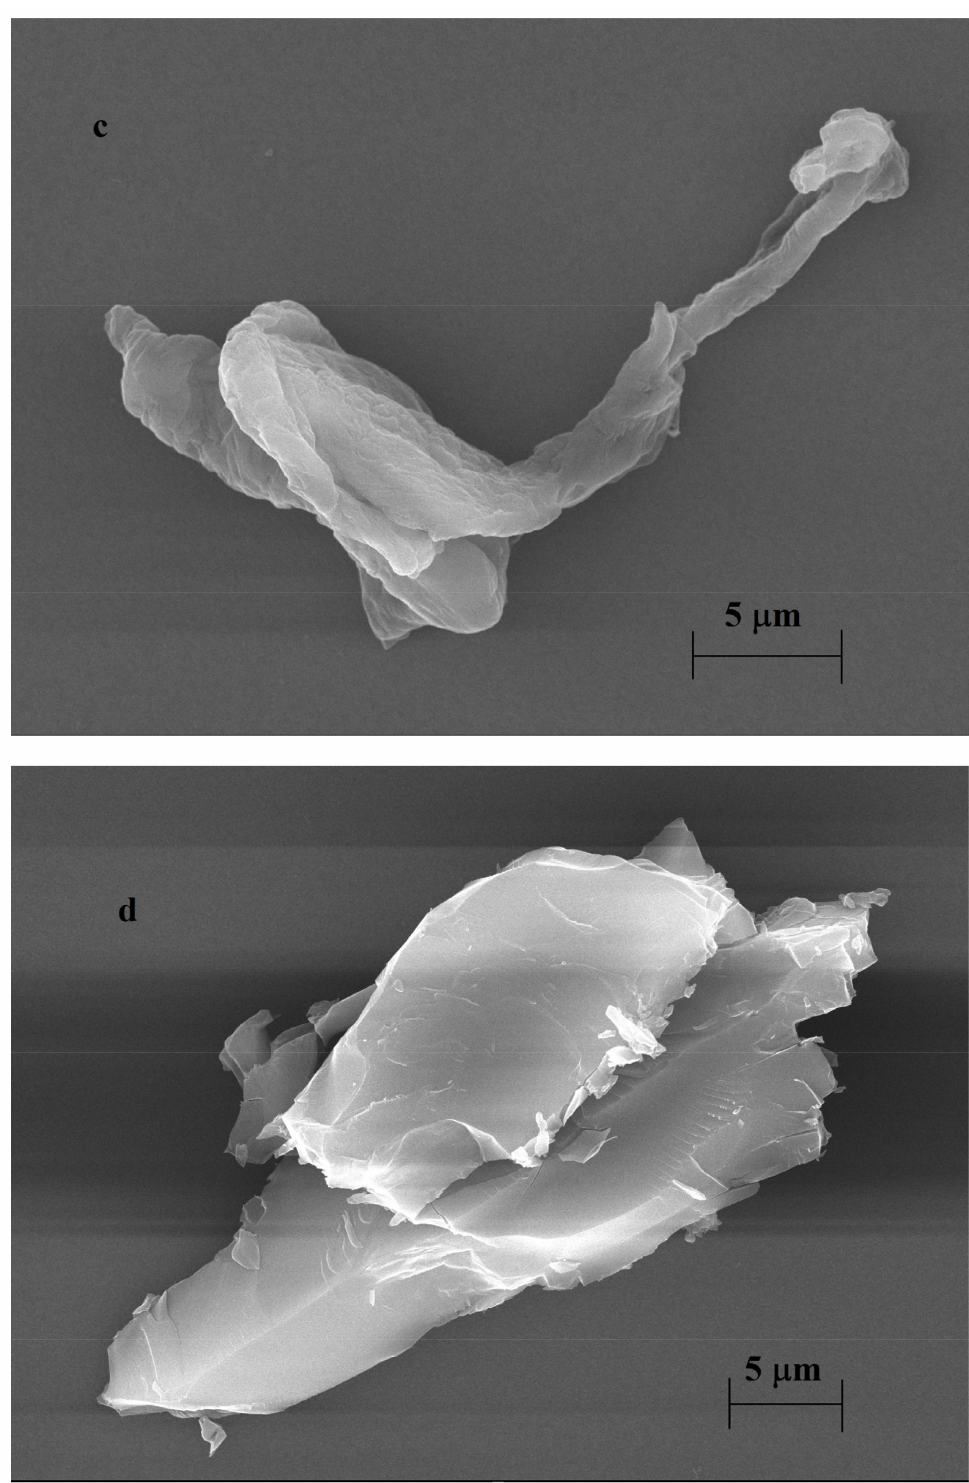
Figure 6. SEM micrographs of deposits of poly(2-phenylphenol) from MIBK ( a ); copolymer of 2- phenylphenol with cavitand ( 1 ) from MIBK ( b ); poly(2-phenylphenol) from MO ( c ); copolymer of 2-phenylphenol and cavitand ( 1 ) ( d ) (concentration of the substrates = 20 mM, electrode = ITO-coated glass slide, and acceleration voltage = 30